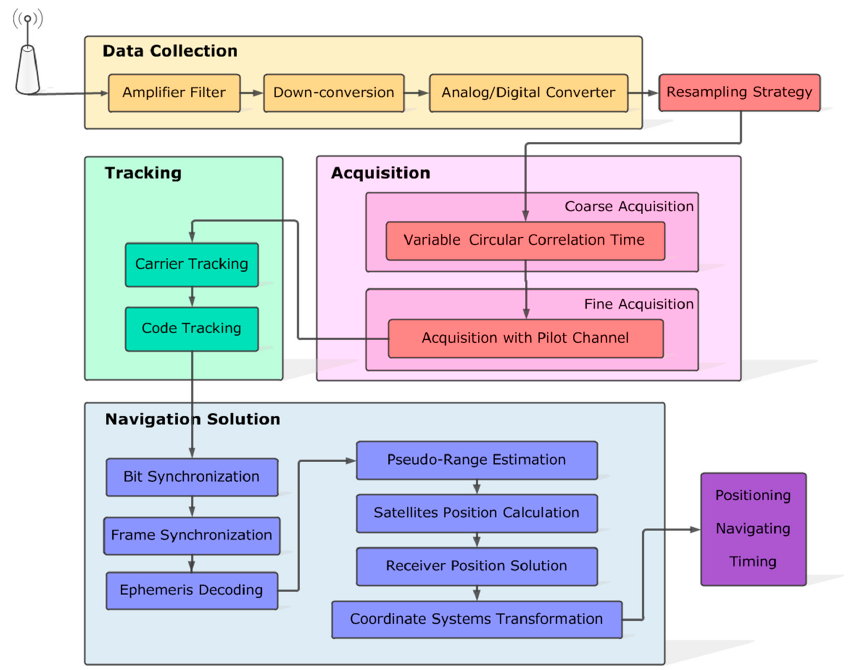
Figure 1. The signal processing framework of GNSS receivers. The modules marked as red are the improved strategies of this paper, including the resampling strategy, variable circular correlation time and acquisition with pilot channel.